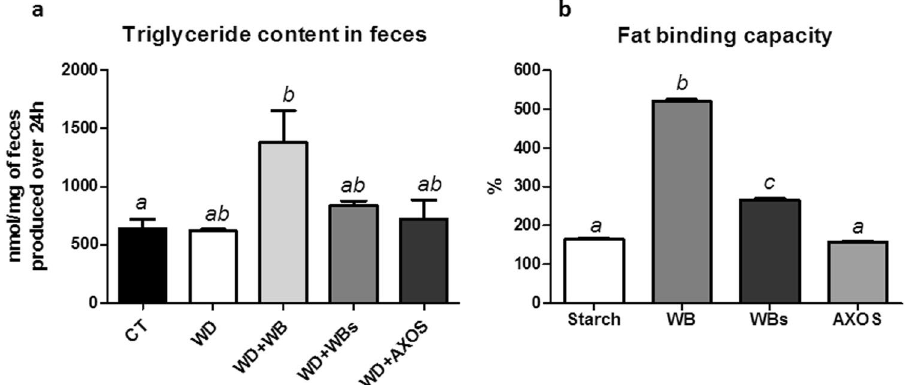
Figure 8. Impact of the three wheat bran fractions on triglyceride excretion in feces and fat binding capacity. Triglyceride content in feces ( a ) of mice fed a control diet (CT), a western diet (WD), a WD supplemented with 5% of wheat bran (WD + WB), a WD supplemented with 5% of wheat bran with reduced particle size (WD + WBs) or a WD supplemented with 5% of AXOS (WD + AXOS) for 8 weeks. In vitro fat binding capacity of starch and cereal fractions for soybean oil ( b ). Results are expressed as mean + SEM (n = 3 for a and n = 5 for b ). Data with different superscript letters are significantly different at p < 0.05 (ANOVA).